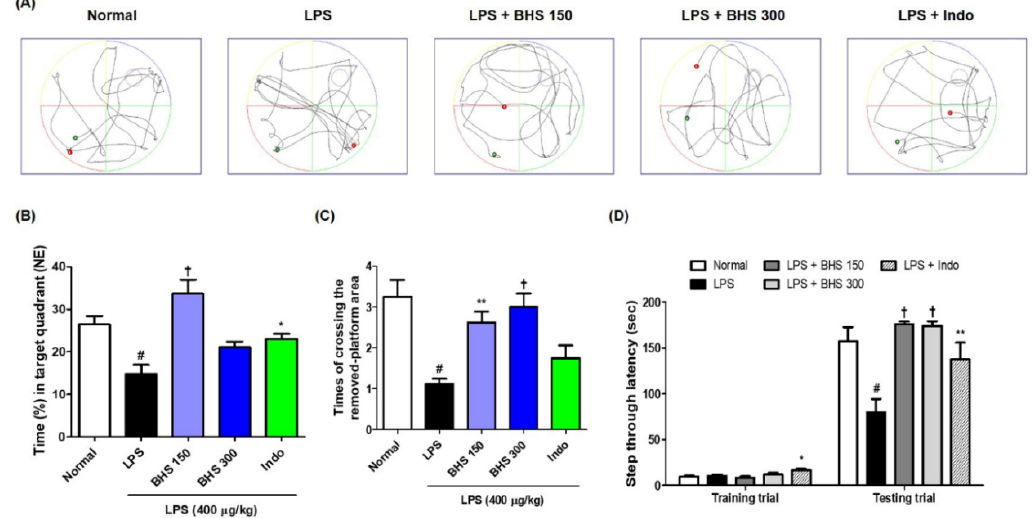
Figure 3. Effects of BHS on mouse memory loss induced by LPS injection, as assessed by probe test ( A – C ) and PA test ( D ). ( A ) Swimming trajectory, ( B ) time spent in NE quadrant, and ( C ) times the mice crossed the removed-platform area in the probe test. ( D ) Step-through latency of training and test trial in PA test. Data represent the mean ± SEM from n = 8 mice. # p < 0.05 (vs. Normal), * p < 0.05, ** p < 0.001, and † p < 0.0001 (vs. LPS) by ANOVA with Dunnett’s post-hoc analysis. BHS, banhasasim-tang (at 150 or 300 mg / kg per day); Indo, indomethacin; LPS, lipopolysaccharide; MWM, Morris water maze; NE, northeast; PA, passive avoidance test.